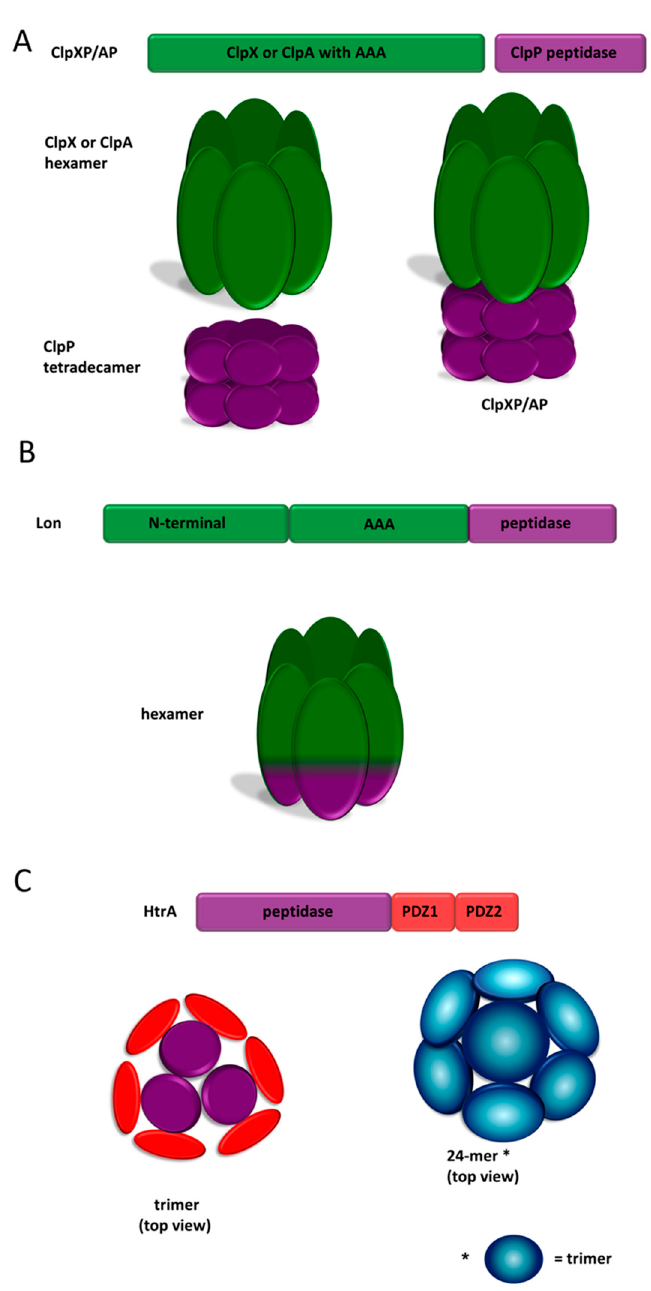
Figure 1. Structures of proteases ClpAP/ClpXP ( A ), Lon ( B ), and HtrA ( C ). Schematic domain structures and exemplary quaternary structures of proteases are presented. The peptidase domain/subunit is shown in purple, the unfoldase domain is green, and the PDZ (post synaptic density protein 95, Drosophila disc large tumor suppressor, and Zonula occludens-1 protein) domain is red.